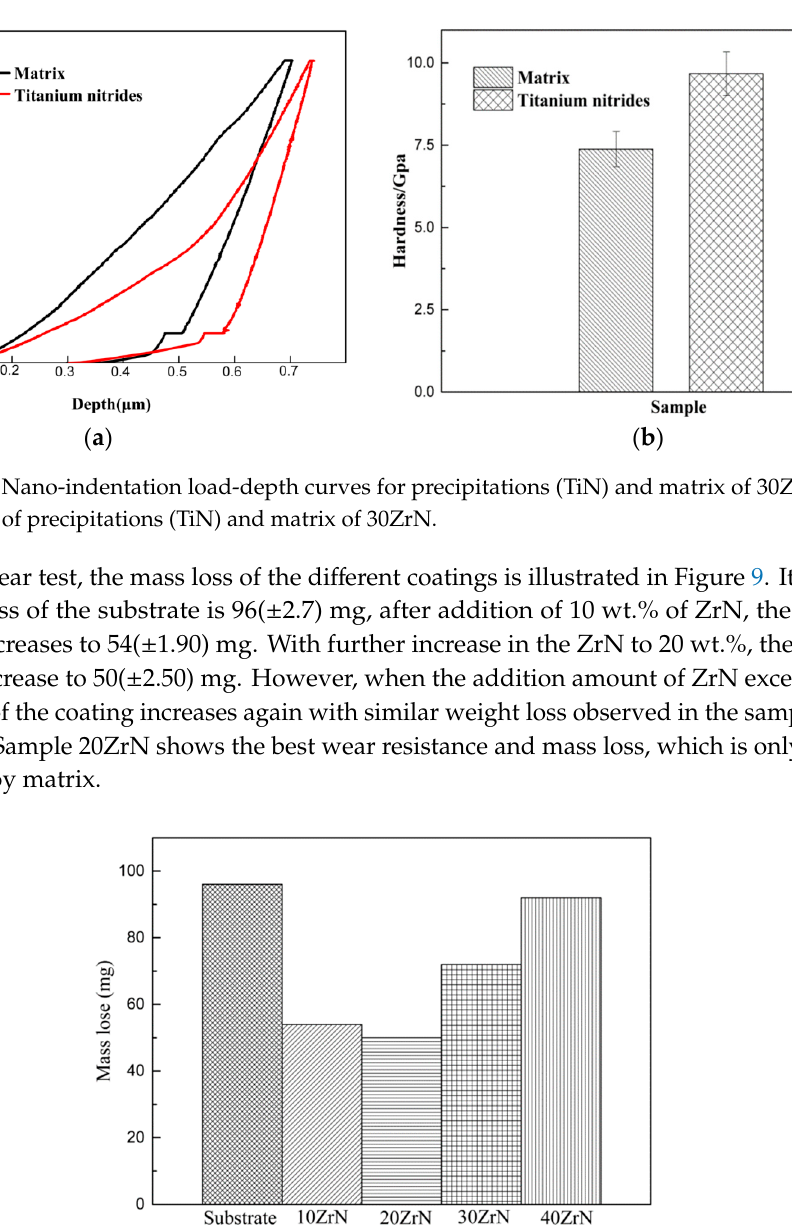
Figure 7. Microhardness of samples with different ZrN additions.